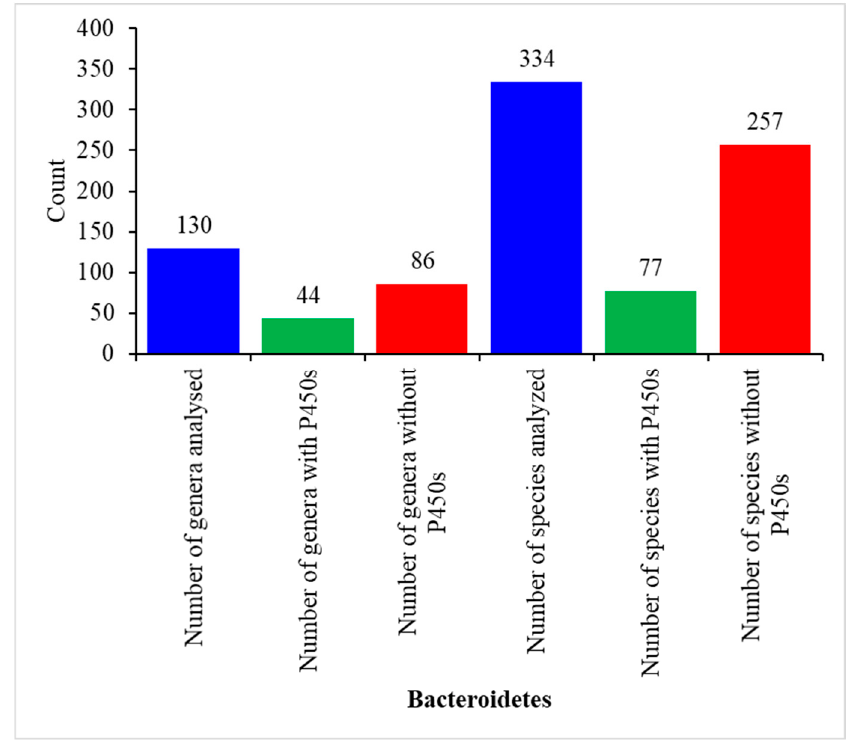
Figure 1. Analysis of P450s in Bacteroidetes species. The number next to the bar indicates the count for that category. Detailed analysis of the species, genera, and P450s are presented in Table S1.